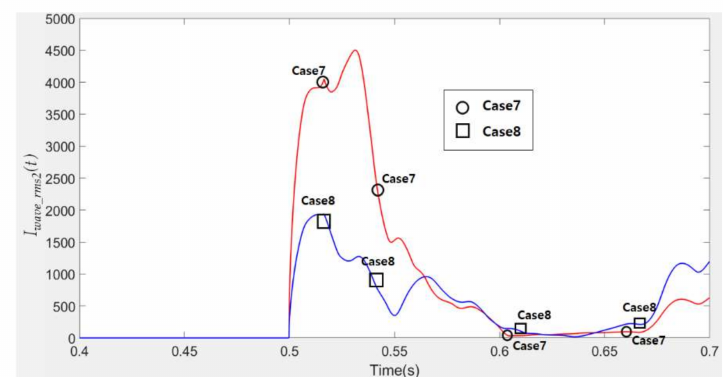
Figure 20. Comparison of I wave_rms 2 ( t ) in Cases 7 and